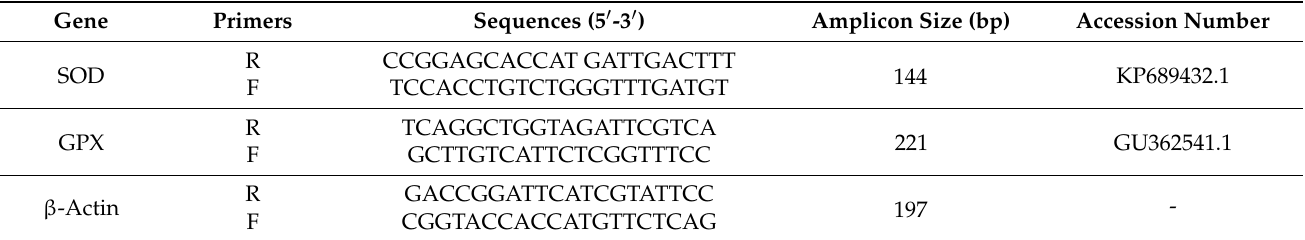
(Table 4). RNA was extracted with Total RNA Isolation Reagent (Trizol, Biosharp BS259A) (Lianshimall.com, Beijing, China) and subsequently isolated in a chloroform layer, precipi- tated in isopropanol [31]. Table 4. Sequences of the qPCR